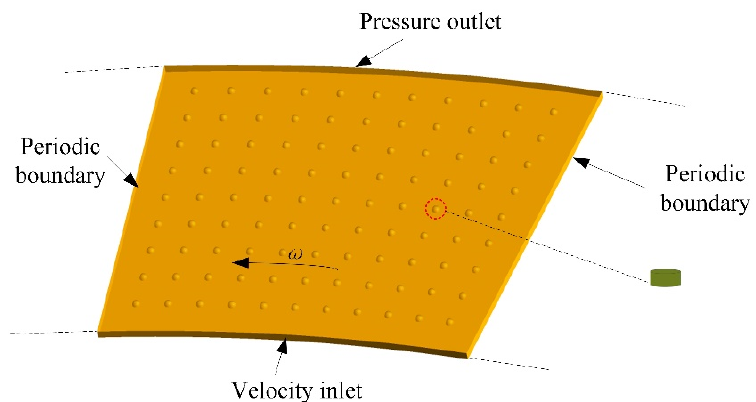
Figure 7. Boundary condition of flow field.